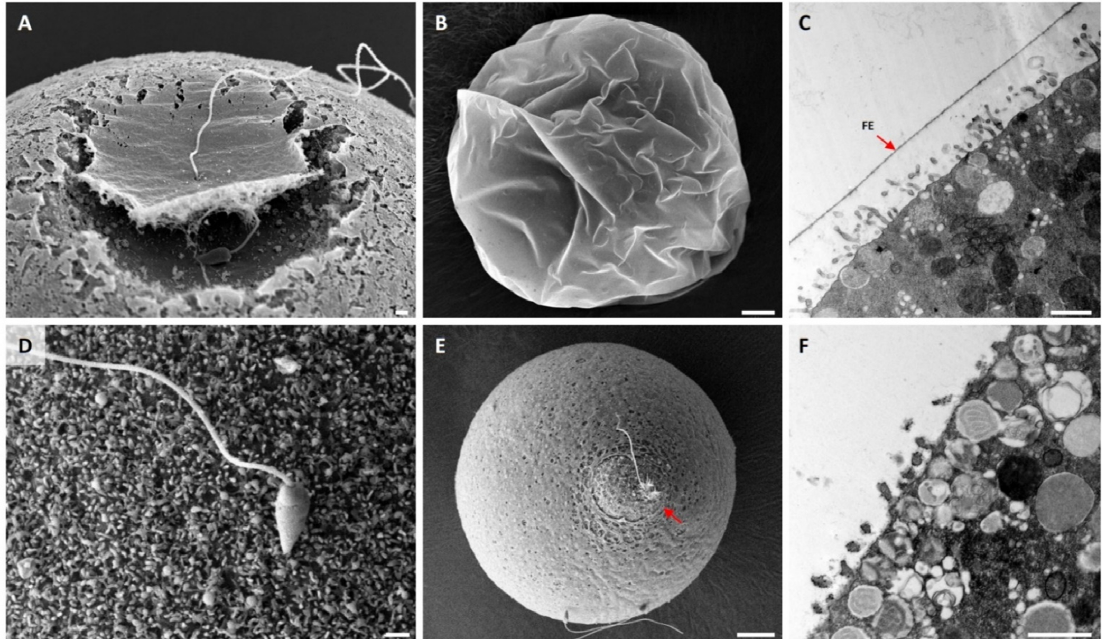
Figure 2. Ultrastructure of the egg surface immediately after fertilization. P. lividus eggs were fertilized and fixed for SEM ( A , B , D , E ) and TEM ( C , F ) analyses. ( A – C ) Control eggs fertilized in NSW. ( D – F ) Eggs preincubated (10 min) and fertilized in seawater containing 10 mM DTT. Images in A and D were captured by fixing the eggs 25 s after insemination. The images in all the other panels show the ultrastructure of the egg surface 1 min after insemination. Note that, in panel E, most parts of a fertilizing sperm were not internalized yet, but were surrounded by the egg protrusion through the ruptured fertilization envelope (red arrow). Scale bars: panels B and E, 10 μ m; all other panels, 1 μ m. FE, fertilization envelope.